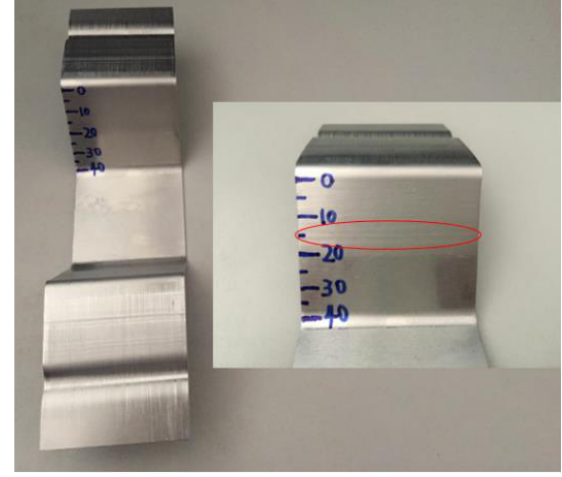
Figure 7. Skid line diagram of forming workpiece surface.